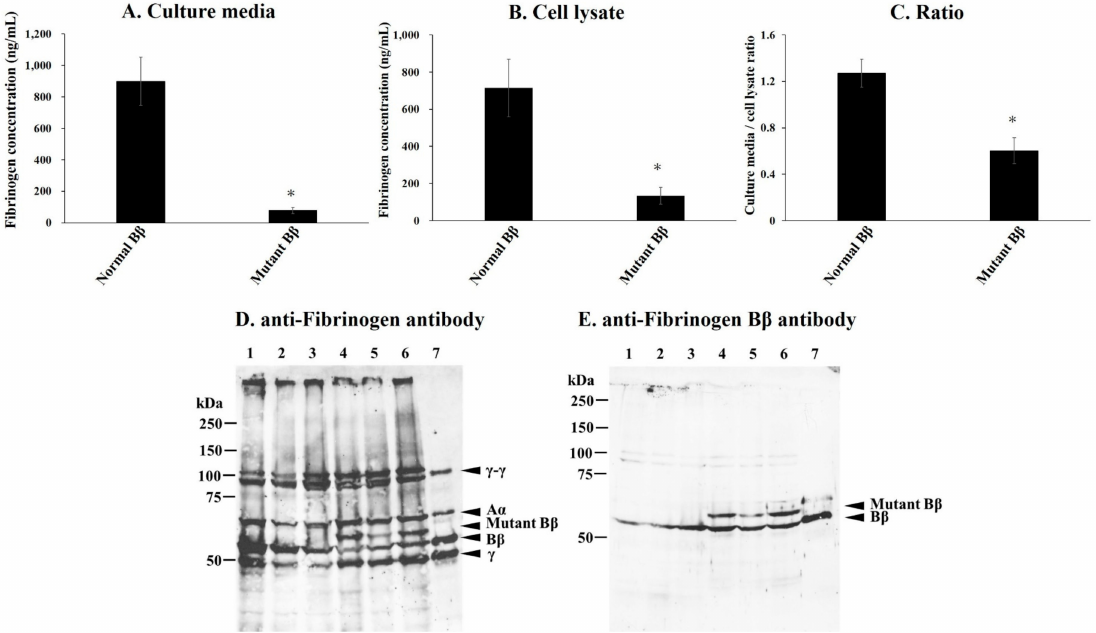
Figure 4. Synthesis of variant fibrinogen in transfected CHO cell lines. Fibrinogen concentrations in culture media ( A ) and cell lysates ( B ) were measured by ELISA as described in the Materials and Methods section. The ratios of the values of the culture media to the cell lysate are shown in ( C ). Mean values are presented with standard deviations indicated by error bars for Normal- B β -Fbg: n = 3, Aberrant- B β -Fbg: n = 3. The culture media, cell lysate, and ratio of the aberrant were significantly different from the normal (*: p < 0.05). ( D , E ): A Western blot analysis of cell lysates. Samples from cell lysates were subjected to 10% SDS-PAGE under reducing conditions. Blots were reacted with an anti-fibrinogen antibody ( D ) and anti-fibrinogen B β antibody ( E ), and detected by chemiluminescence as described in the Materials and Methods section. Lanes 1–3: Normal B β -Fbg synthesized in CHO cell lines, Lanes 4–6: Aberrant B β -Fbg synthesized in CHO cell lines, Lane 7: purified fibrinogen from normal plasma. The left sides of Panels D and E show molecular size